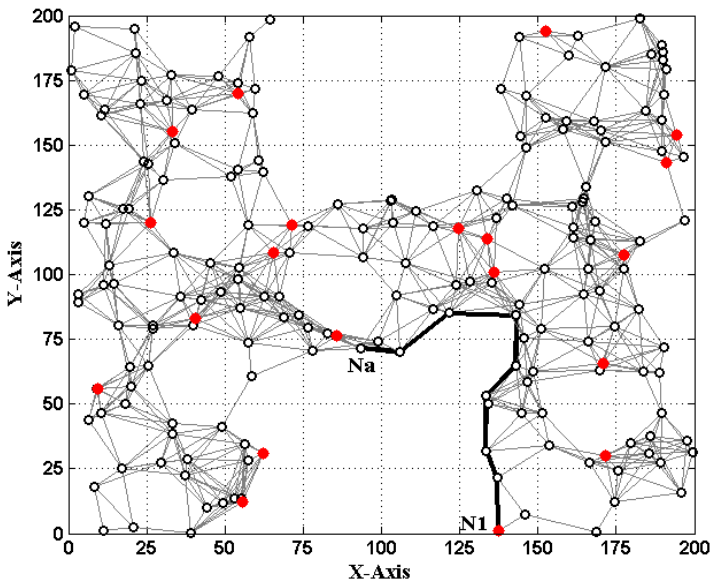
Figure 2. Anisotropic network (H